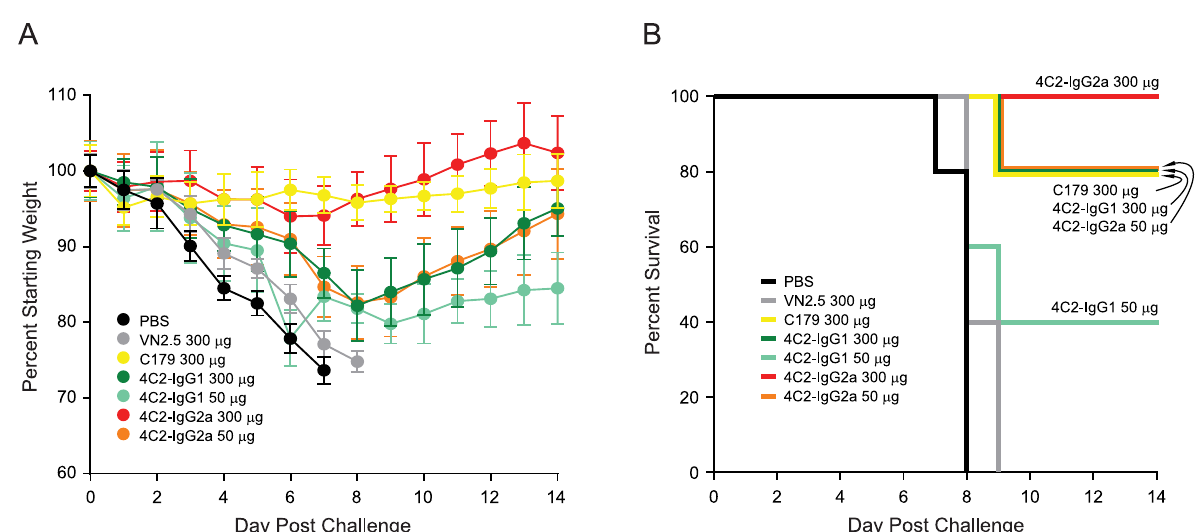
Fig 4. MAb 4C2 protects mice from influenza challenge. Mice (5 per group) were inoculated intraperitoneally with PBS or the indicated MAb doses 6 h before being challenged with 5 LD 50 of A/Puerto Rico/8/1934 virus. Mice were observed 2 weeks for body weight loss and/or death. (A) Average percentage change in body weight post-challenge. Bars: standard deviations. (B) Survival curves post-challenge. Similar results were obtained in two additional independent challenge experiments.